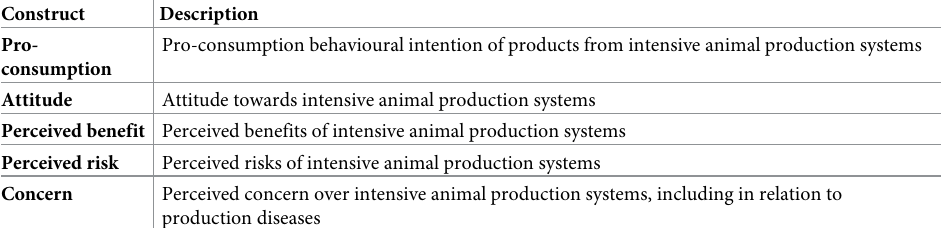
Table 8. The five variables included in the structural equation modelling analysis.